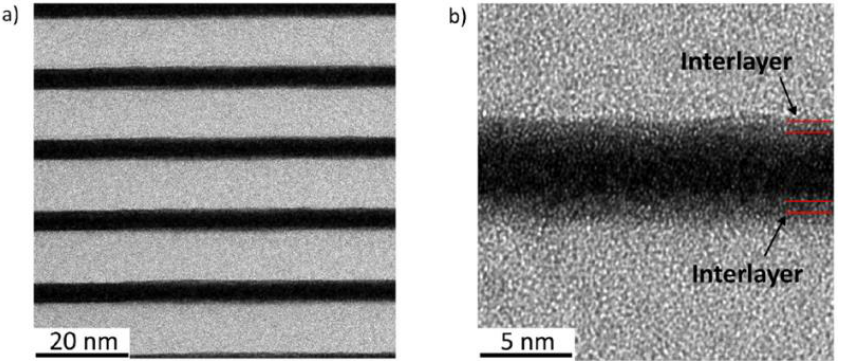
Figure 4. Illustration of intermixing in PMMs. ( a ) Cross-sectional high-resolution TEM image of Mo/B PMMs; ( b ) magnification of the central area. Reprinted from [44] with permission from Else- vier.